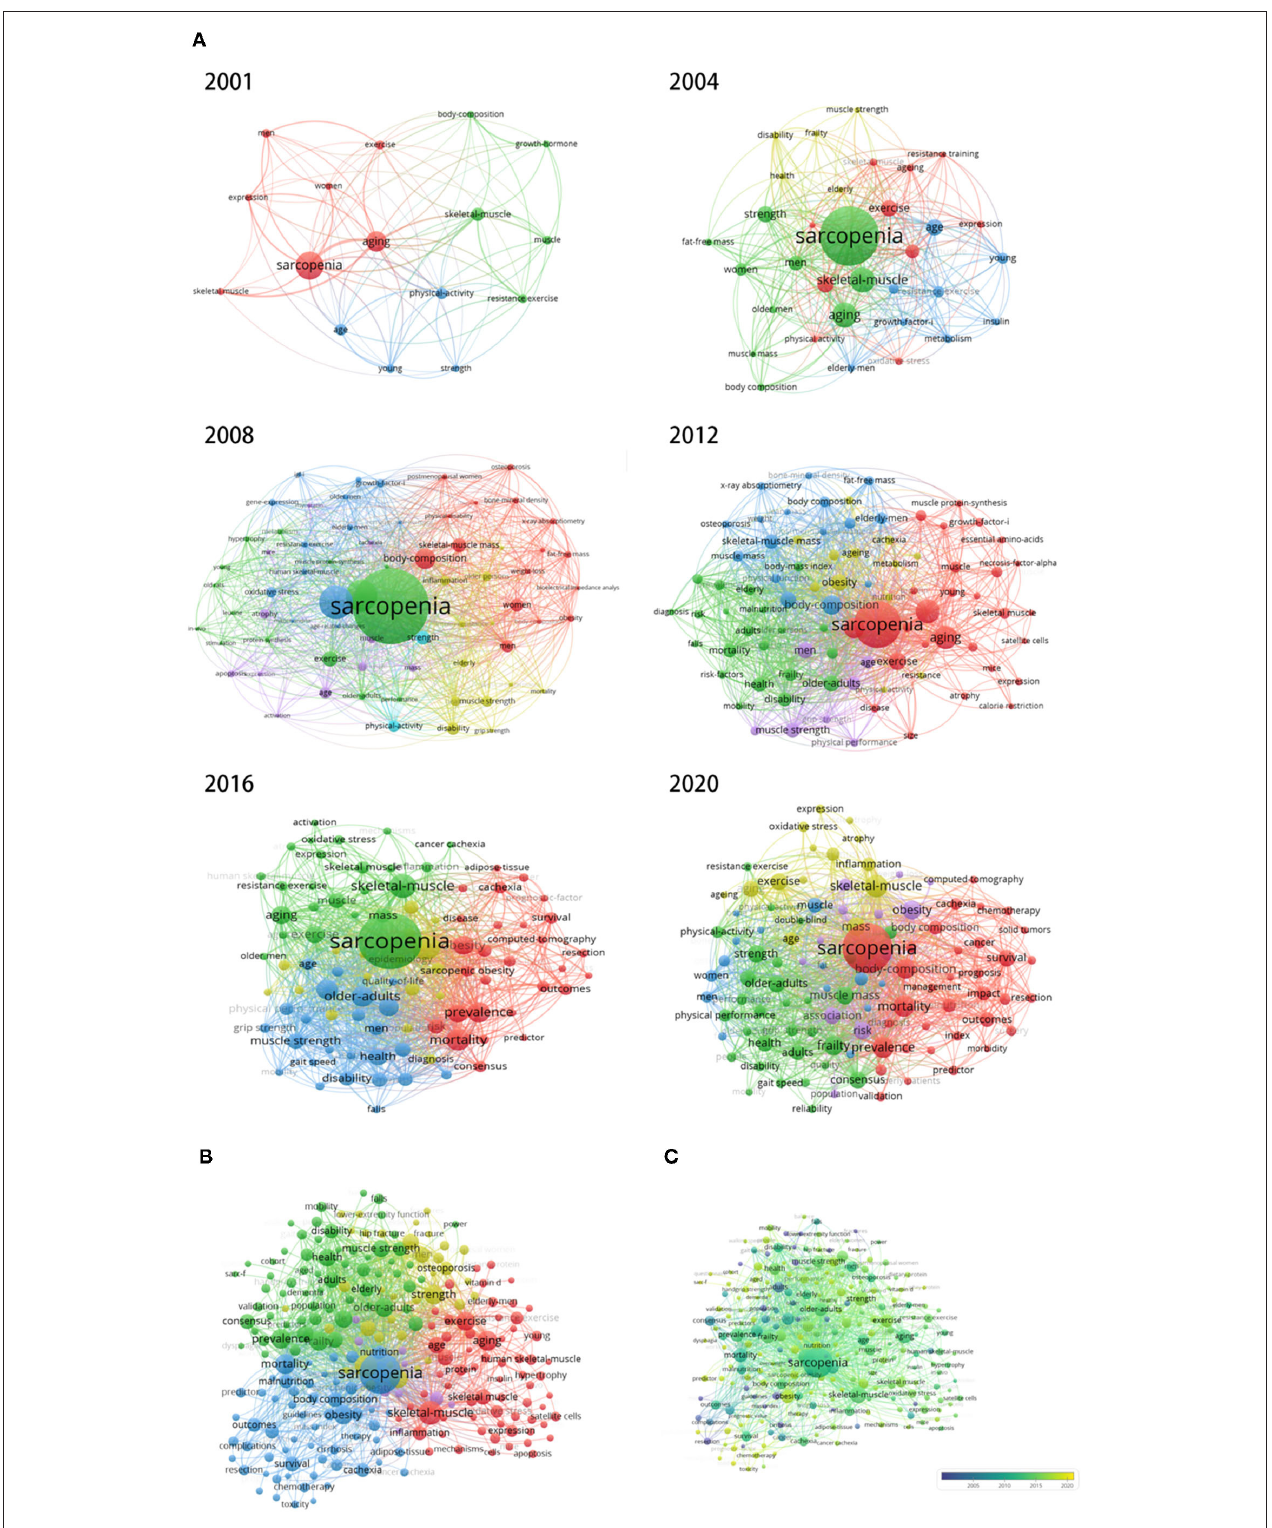
FIGURE 4 | Keyword maps globally. (A) Global keyword maps in different years. (B) Keyword maps in the past 20 years. In this visualized network, each keyword is represented by a node. Node size reflects the number of publications in the node, and the distance between two nodes indicates the connectivity of the nodes as determined by co-occurrences. The larger the number of publications for which two nodes are both found, the stronger the relationship between the nodes. VOS viewer has its clustering technique based on citation relations between clusters. Colors represent groups of nodes that are relatively strongly related to each other. (C) Distribution of keywords according to their time of appearance. Keywords in blue appeared earlier than those in yellow.